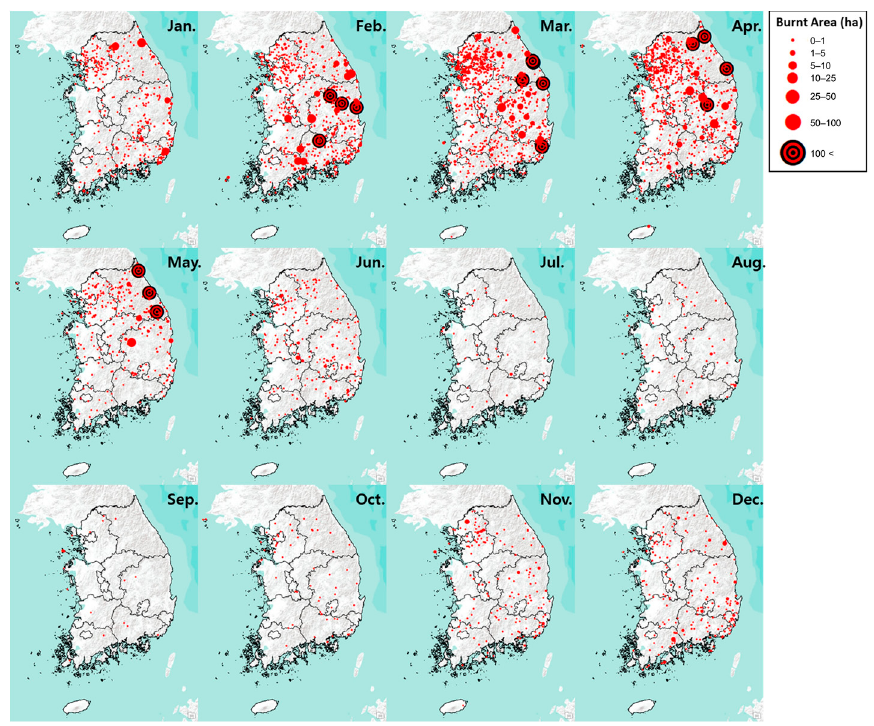
Figure 1. Patterns of the forest fires frequency and their scale in South Korea (from Jan. 2016 to Mar. 2022).